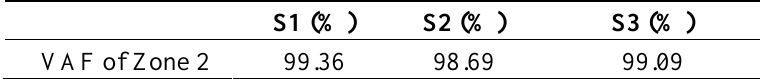
Table 3. The VAF of each sensor.